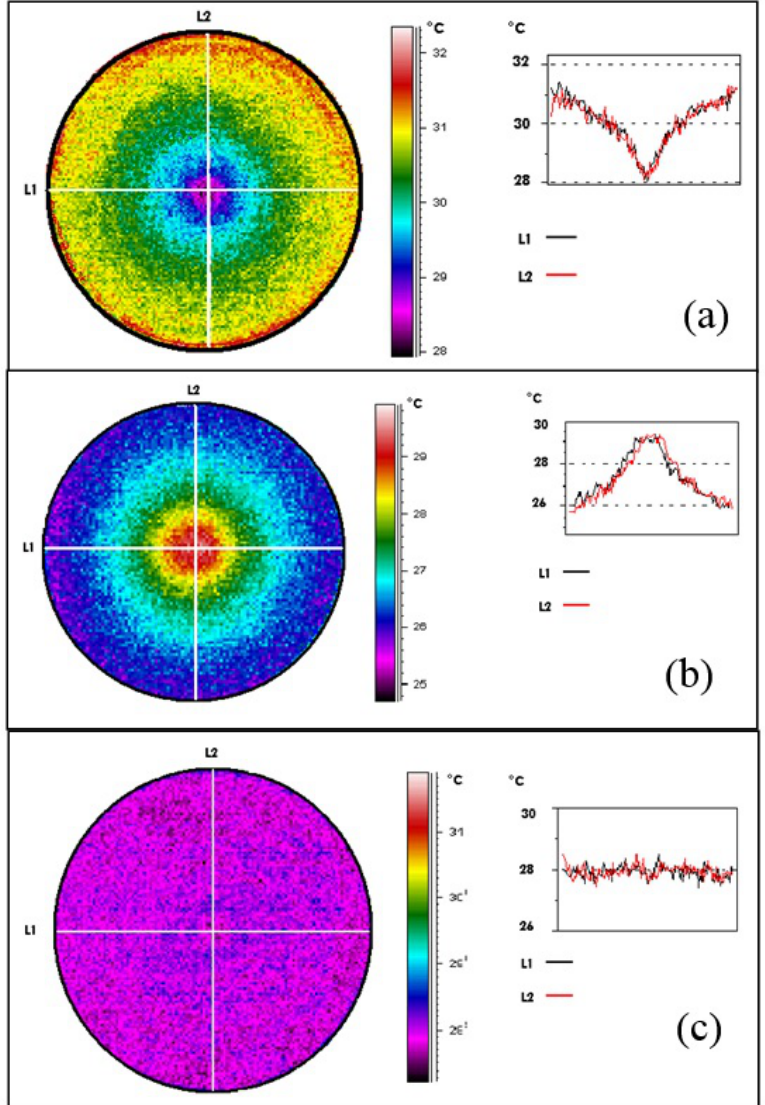
Figure 2. Temperature distribution on dry blotting paper for several cases: ( a ) (top) positive mean gradient, ( b ) (middle) negative mean gradient, and ( c ) (bottom) isothermal case. Thermographies are on the left-hand side, while the measured temperature profiles are on the right-hand side. The respective profiles fit approximately Equation (1), and fluctuations are related to the measurement error, which in these cases was around ± 0.1 ◦